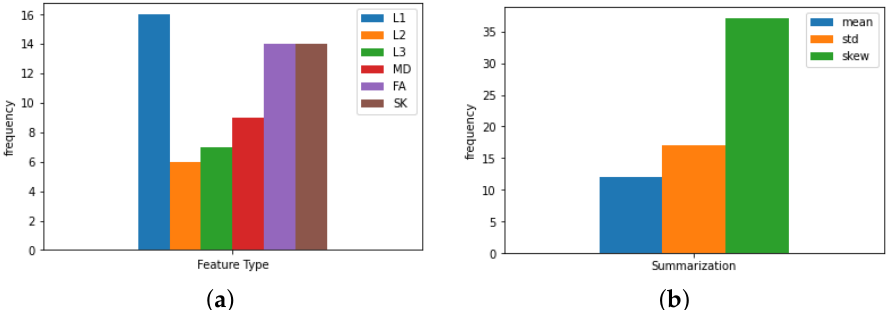
Figure 2. Histogram of types of selected summary statistic features. ( a ) for the occurances of each feature type, ( b ) for summary statistics